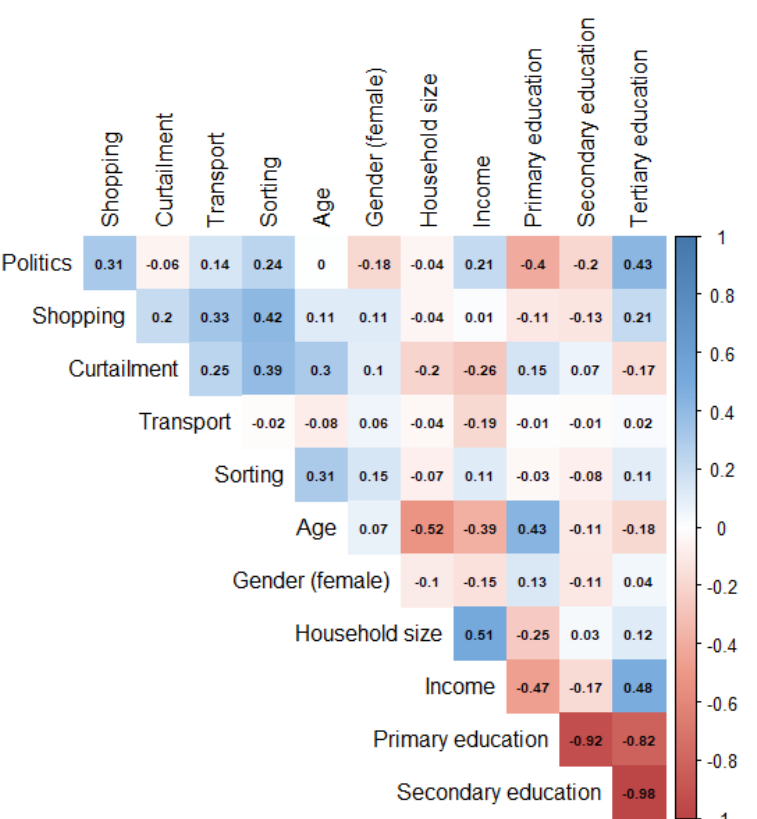
Figure 1. Correlation matrix i.e., correlations between all variables included in the analysis. Darker cells indicate a stronger relationship between two variables. White cells indicate a non-significant relationship ( p -value > 0.05).